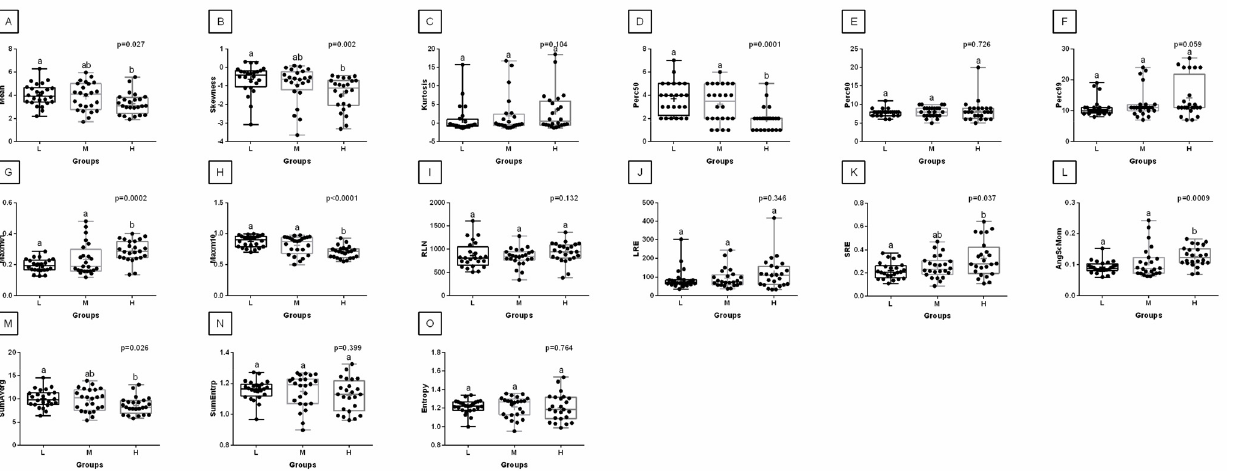
Figure 7. Analysis of texture features for the blue component compared between light (L), moderate (M), and heavy (H) groups in the first regions of interest (ROI 1). Differences between groups were indicated with individual p -values when p < 0.05. Different superscripts on each plot were statistically different. ( A ) Mean; ( B ) Skewness—skewness coefficient; ( C ) Kurtosis; ( D – F ) Perc50, Perc90, Perc99—percentiles; ( G , H ) Maxm01, Maxm10—maximum of moments; ( I ) RLN—run-length nonuniformity; ( J ) LRE—long-run emphasis; ( K ) SRE—short-run emphasis; ( L ) AngScMom—angular second moment/energy; ( M ) SumAverg—summation mean; ( N ) SumEntrp—summation entropy; ( O ) Entropy. Data are presented using minimum and maximum values, lower and upper quartiles, and median. The mean value is marked by a cross.